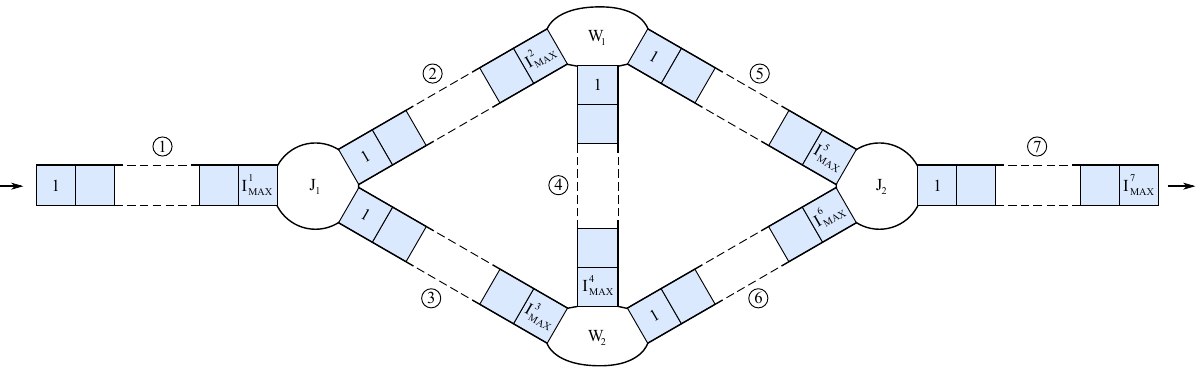
Figure 13. (Scheme of the looped pipe network.